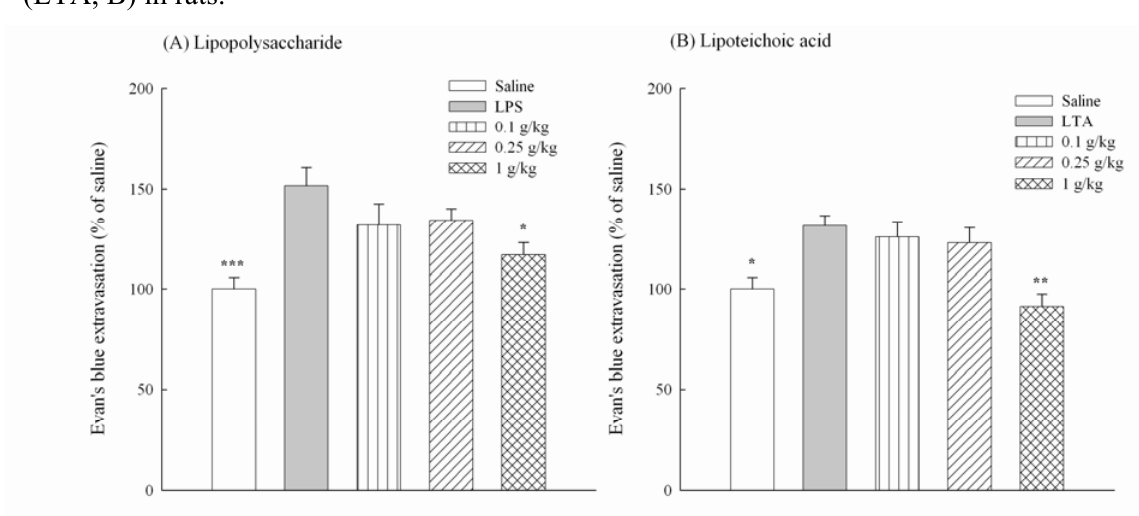
Figure 4. Effects of methanol extracts from Ligustrum pricei (0.1, 0.25, 1 g/kg) on microvascular permeability increased by lipopolysaccharide (LPS, A) and lipoteichoic acid (LTA, B) in rats.